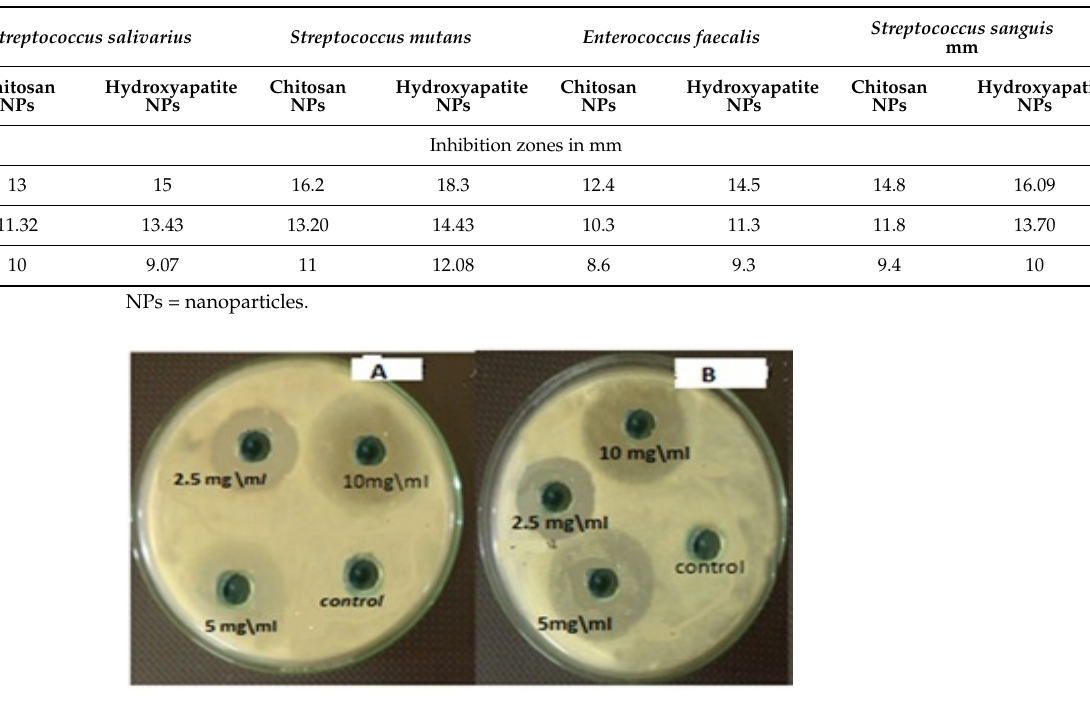
Figure 10. Antibacterial activity of different concentrations of HAPNPs and chitosan NPs against oral mouth bacteria. ( A ) Antibacterial activity of different concentrations of HAPNPs against Streptococcus mutans , ( B ) Antibacterial activity of different concentrations of chitosan NPs against Streptococcus mutans . The results of the MIC value of CSNPs against testedoral bacteria are seen in Table 2, Figure 11. The MIC values of CSNPs were 8 µ g/mL on E. faecalis , S. mutans and S. salivarius , with St. deviation ± 0.07, 0.014 respectively, while this was 16 µ g/mL on S. sanguis with St. deviation ± 0.014. At the same time, the MBC of CSNPs was evaluated, as presented in Table 3. The same values were found for S. salivarius, S. mutans and E. faecalis (4 µ g/mL) with St. deviation ± 0.07, 0.28 respectively, while the MBC of CSNPs should be S. sanguis was 8 µ g/mL with St. deviation ± 0.014. Table 2. Minimum Inhibitory Concentration (MIC) and Minimum Bacterial Concentration (MBC) of CSNPs.